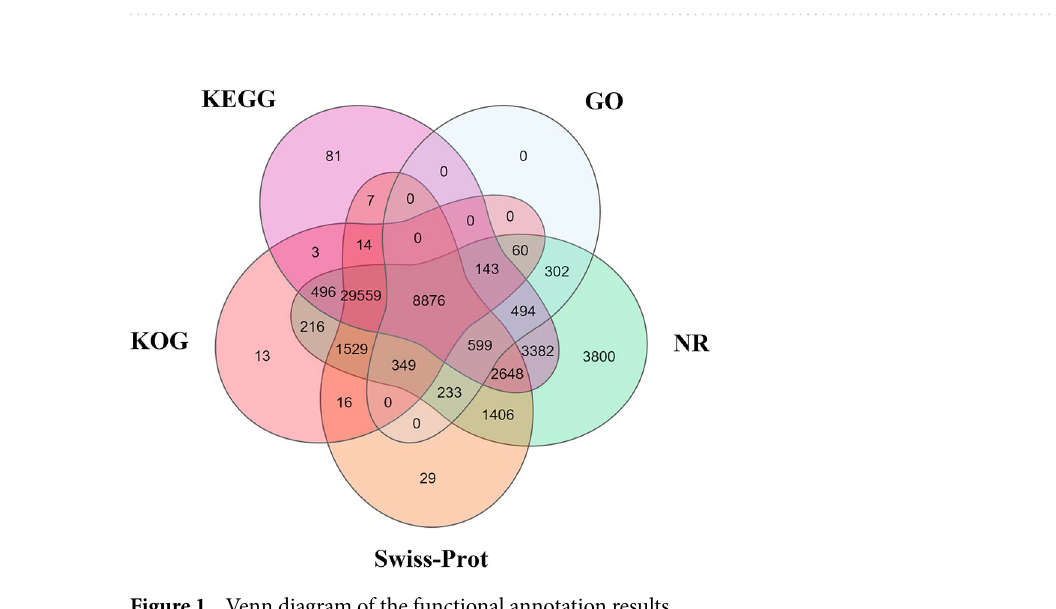
Figure 1. Venn diagram of the functional annotation